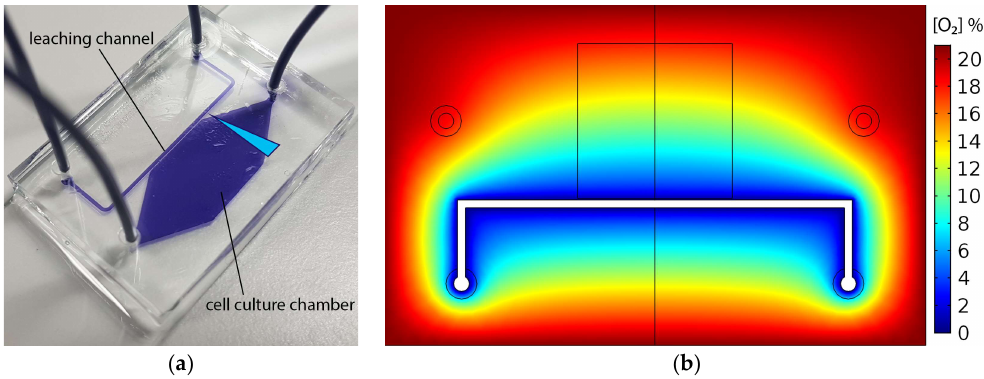
Figure 1. The microfluidic chip with simulated oxygen distribution at the glass cell culture surface: ( a ) Picture of the microfluidic device filled with blue dye. The polydimethylsiloxane (PDMS) is 25 × 30 mm with a height of 2 mm, and bonded to a 25 × 75 mm glass microscope slide. The diffusion barrier on top is 0.5 mm thick, and has the same dimensions as the PDMS. The gradient direction in the chamber is indicated with a blue triangle and ( b ) simulation of the steady-state oxygen distribution in the chip. The chamber outline and chip symmetry line are shown in black.